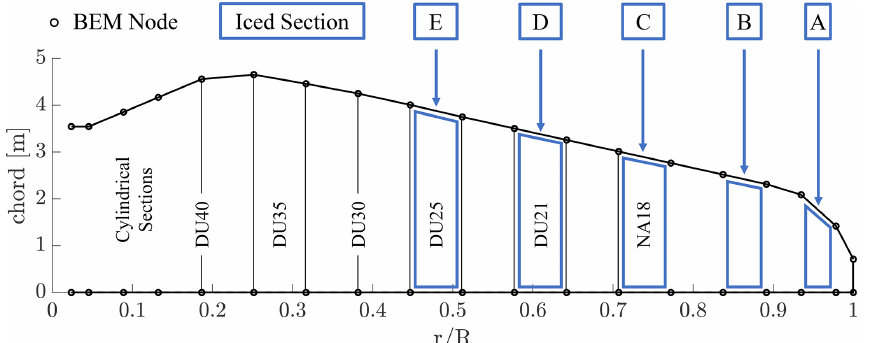
Figure 3. Blade discretisation and sections chosen for ice accretion.